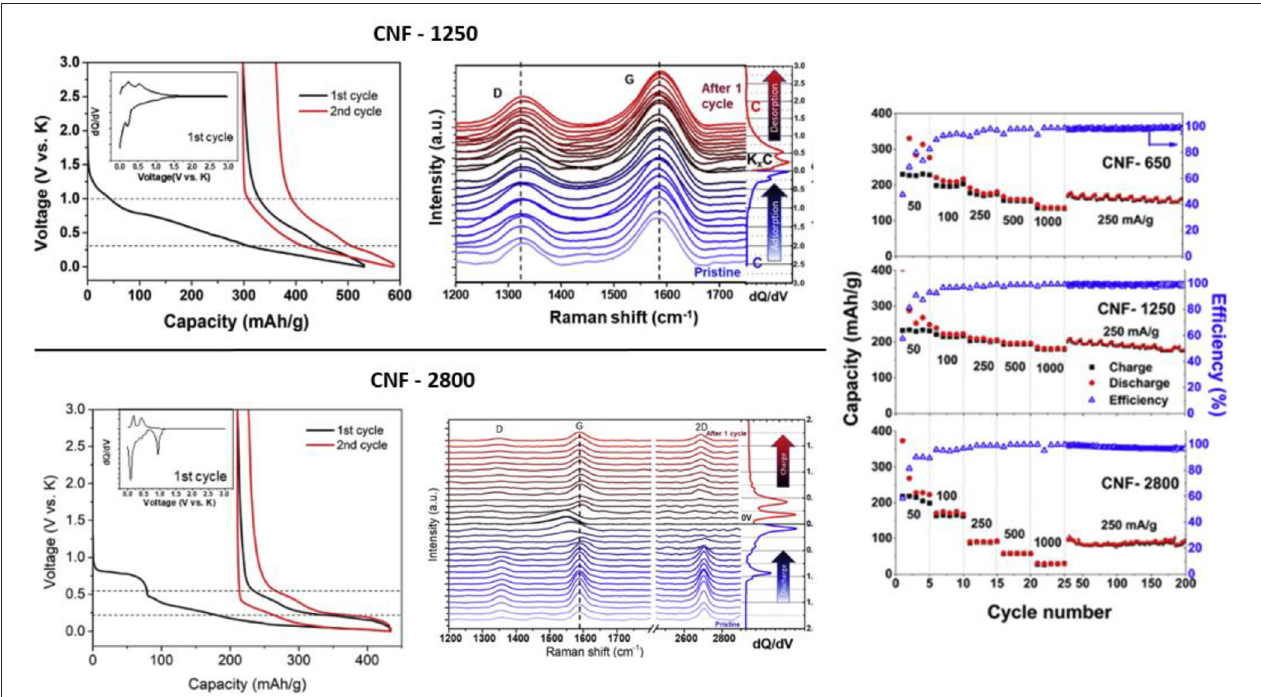
FIGURE 3 | Left, potential profile at 25 mA/g and in situ Raman spectra of CNF annealed at 1,250 ◦ C (top) and CNF annealed at 2,800 ◦ C (bottom). Right, rate capability of CNF electrodes. Adapted from Lin et al. (2019) with permission from